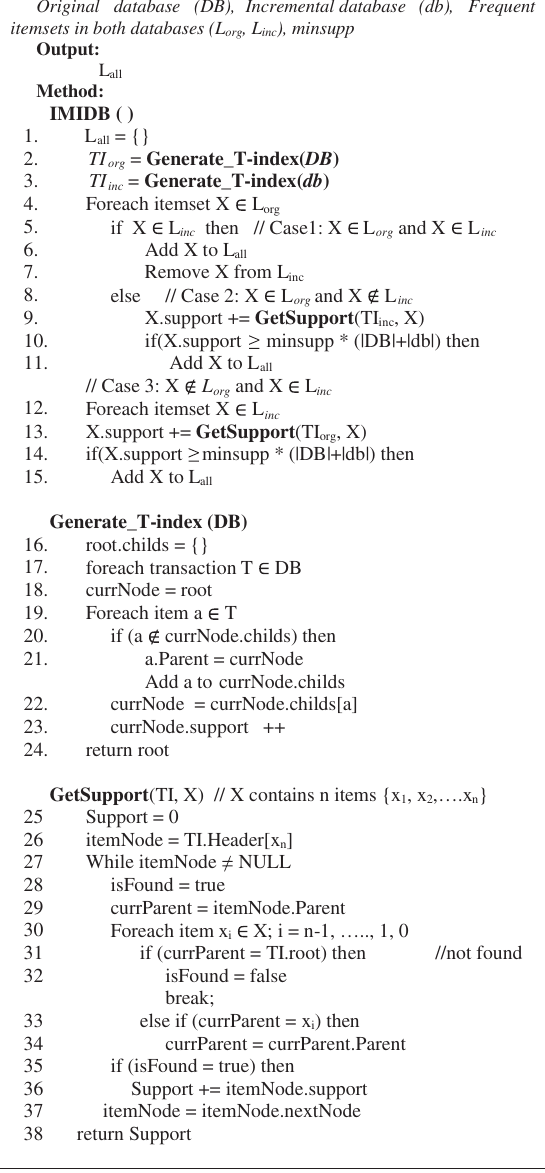
Figure 4: The Proposed IMIDB